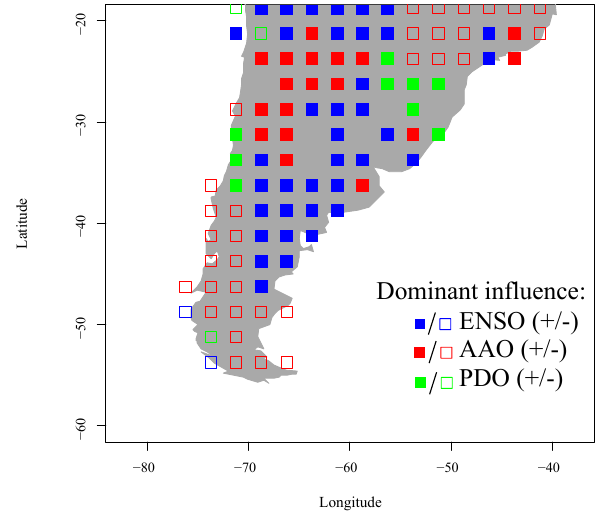
Figure 15 . Map of the magnitude and direction of the dominant influence, (measured as the magnitude and sign of the largest regression coefficient in the following equation: PDSI = a(AAO)+ b(ENSO)+c(PDO)). Red symbols represent a dominant AAO influence while blue and green symbols indicate a dominant ENSO or PDO influence, respectively. Filled (empty) squares denote a positive (negative) influence on summer PDSI. The regression was performed for the longest common period (1950-1993). Spots with no symbols had a negative RE value.